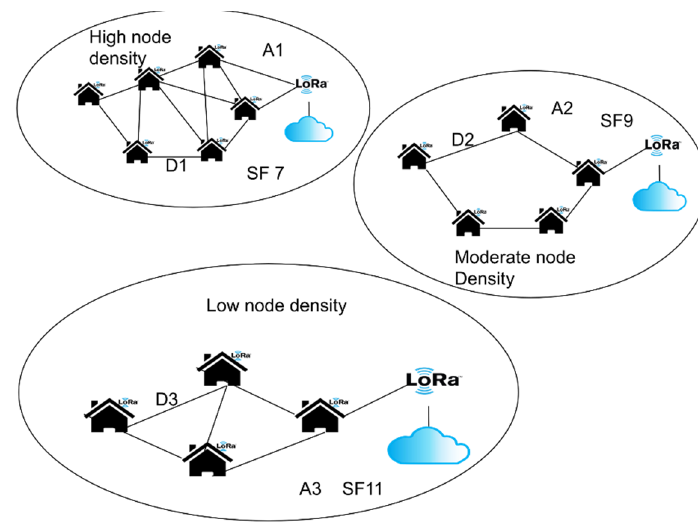
Figure 8. Network management in large scale.